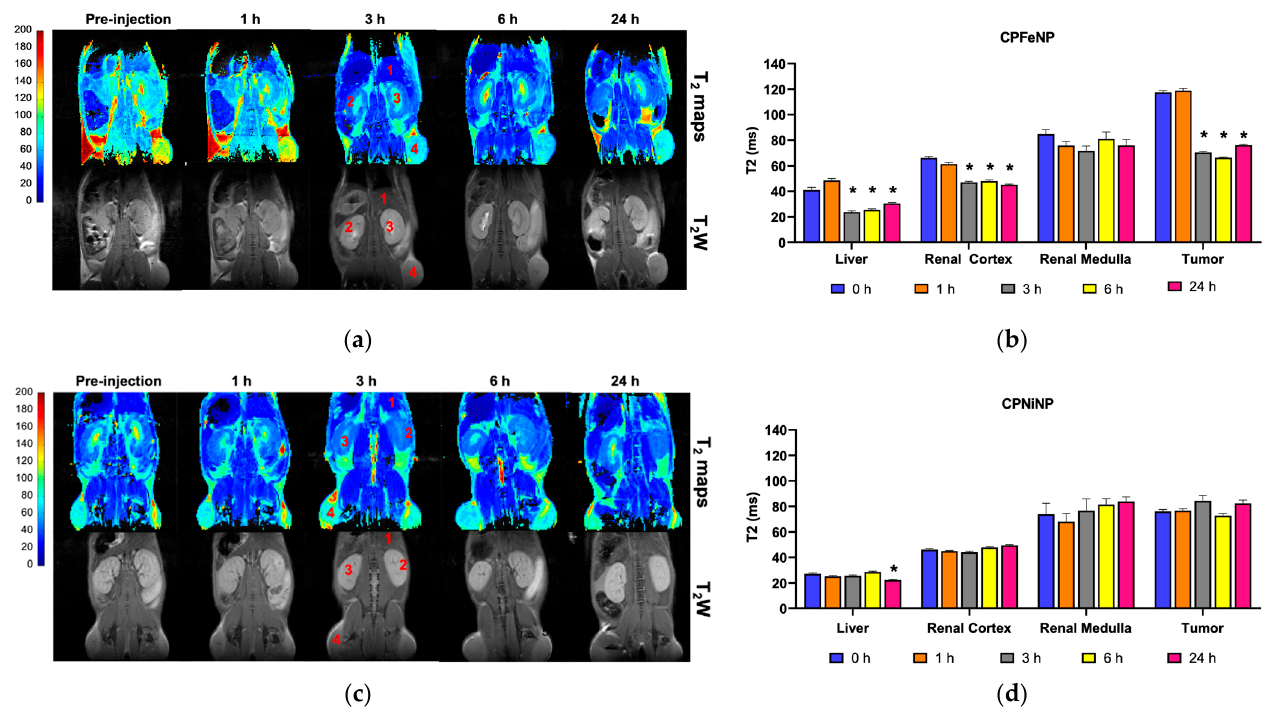
Figure 7. T 2 color ‐ code based maps and T 2 W images of heterotopic GBM model. T 2 color ‐ code based maps and T 2 W images acquired before the i.v. administration of the IONP ‐ doped CPNs, and at 1, 3, 6 and 24 h after the injection. Numbers indicated the tissues where the ROIs were selected to do the measurements: 1, liver; 2, renal cortex; 3, renal medulla; 4, tumor. ( a ) CPFeNP MRI evaluation; ( c ) CPNiNP MRI evaluation. Graphics show the variation in T 2 values (mean ± SEM) along the temporal evaluation: ( b ) CPFeNP; ( d ) CPNiNP. Statistical symbols correspond to the comparison of the data to the pre ‐ injection value (* p < 0.05).